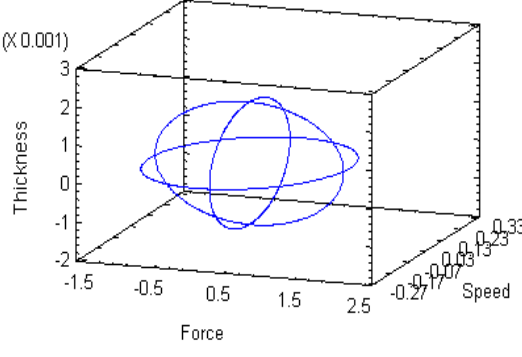
Figure 47. “Control ellipsoid for MEWMA chart for the regressed data”.